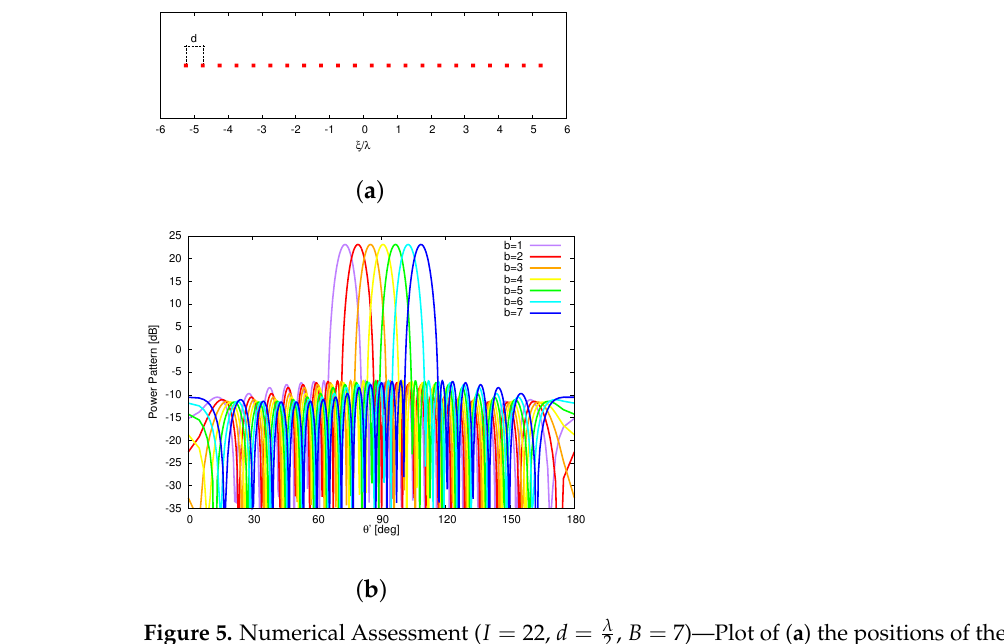
, B = 7)—Plot of ( a ) the positions of the elements of 2